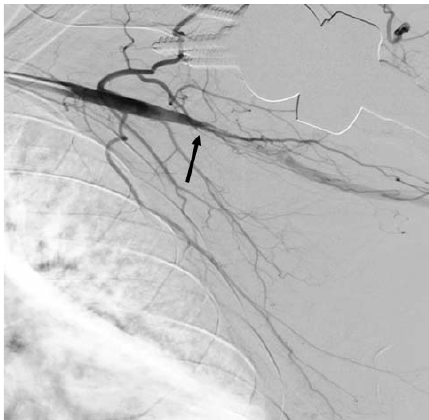
Figure 1: Angiography of the left upper extremity showing total occlusion of the axillary artery (arrow).